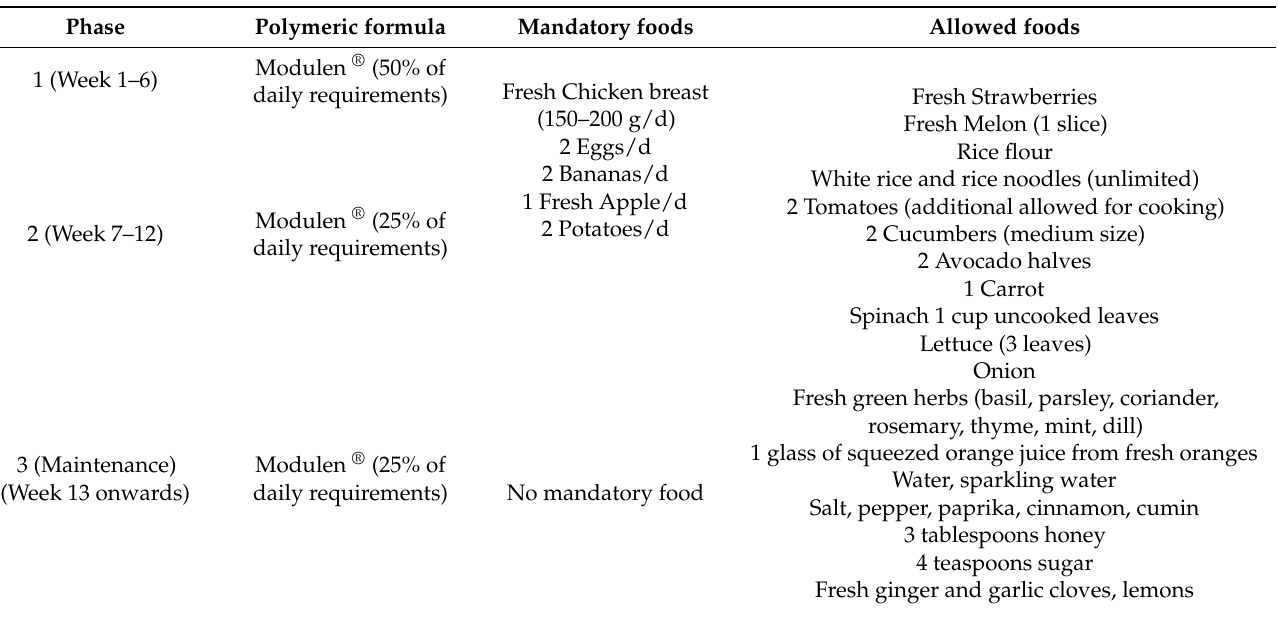
Table 3. Example of Crohn Disease Exclusion Diet - adapted from